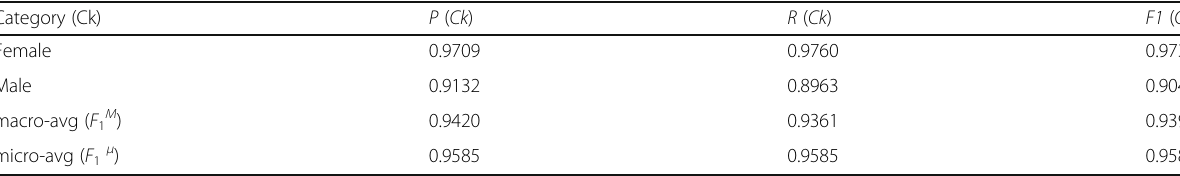
Table 3 Results with binary approach with cross validation = 3